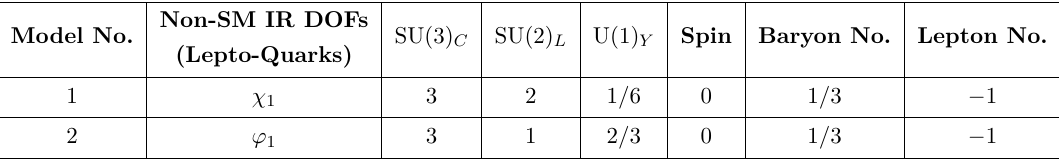
Table 18 . Additional IR DOFs (Lepto-Quarks) as representations of the SM gauge groups along with their spin and baryon and lepton